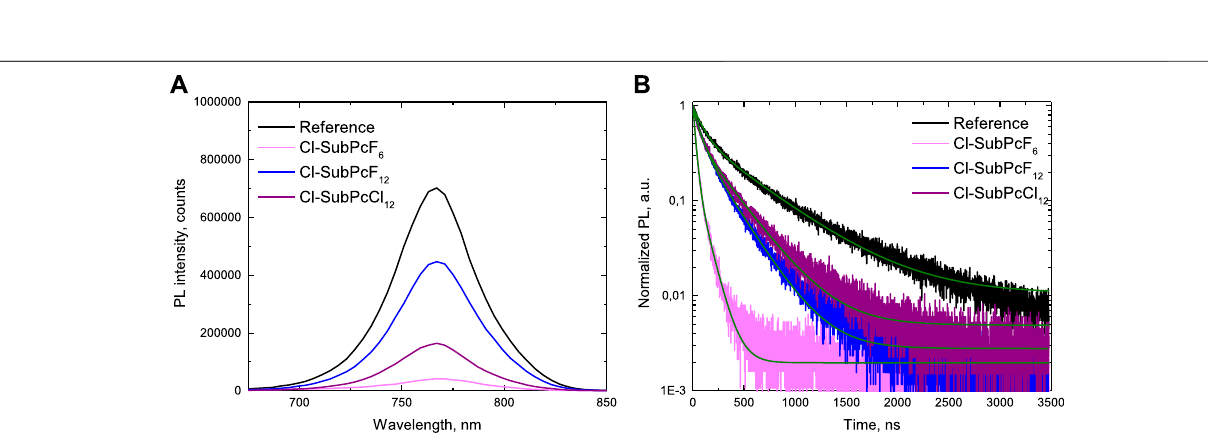
FIGURE3|(A) J – V curvehysteresisof Cl-SubPcF 6 . (B) stabilityofthePSCscontaining2 nm-vacuumdeposited Cl-SubPcF 6 , Cl-SubPcF 12 and Cl-SubPcCl 12 layers, measured under one sun illumination in power point tracking conditions in air. (C) Images of the water droplet contact angles on the surfaces of the perovskite (reference) and perovskite/SubPc, Cl-SubPcF 12 , Cl-SubPcF 6 , and Cl-SubPcCl 12 thin fi lms.